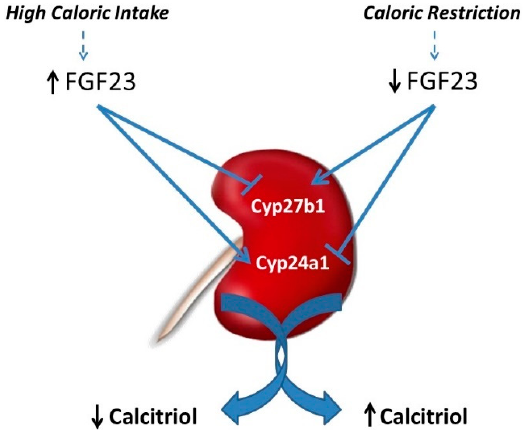
Figure 3. Calcitriol regulation by caloric intake is secondary to changes in fibroblast growth factor 23 (FGF23). The increase in FGF23 after high caloric intake down-regulates Cyp27b1 (involved in calcitriol synthesis) and upregulates Cyp24a1 (that metabolizes calcitriol) leading to decreased calcitriol concentrations. Conversely, the decrease in FGF23 after calorie restriction upregulates Cyp27b1 and down-regulates Cyp24a1 resulting in increased calcitriol concentrations.